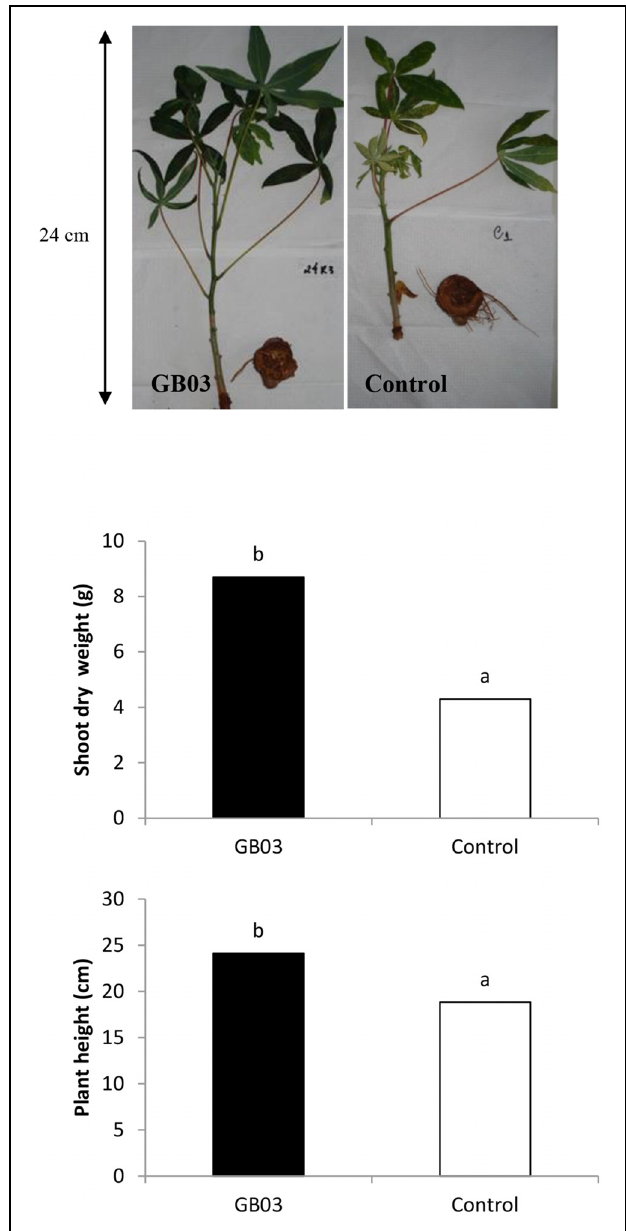
FIGURE 1 | Growth promotion of cassava ( Manihot esculenta ) cv. IAC 576-70 mediated by Bacillus subtilis GBO3 compared to the water control. Mean ( n = 3) shoot dry weight and plant height at 150 days after